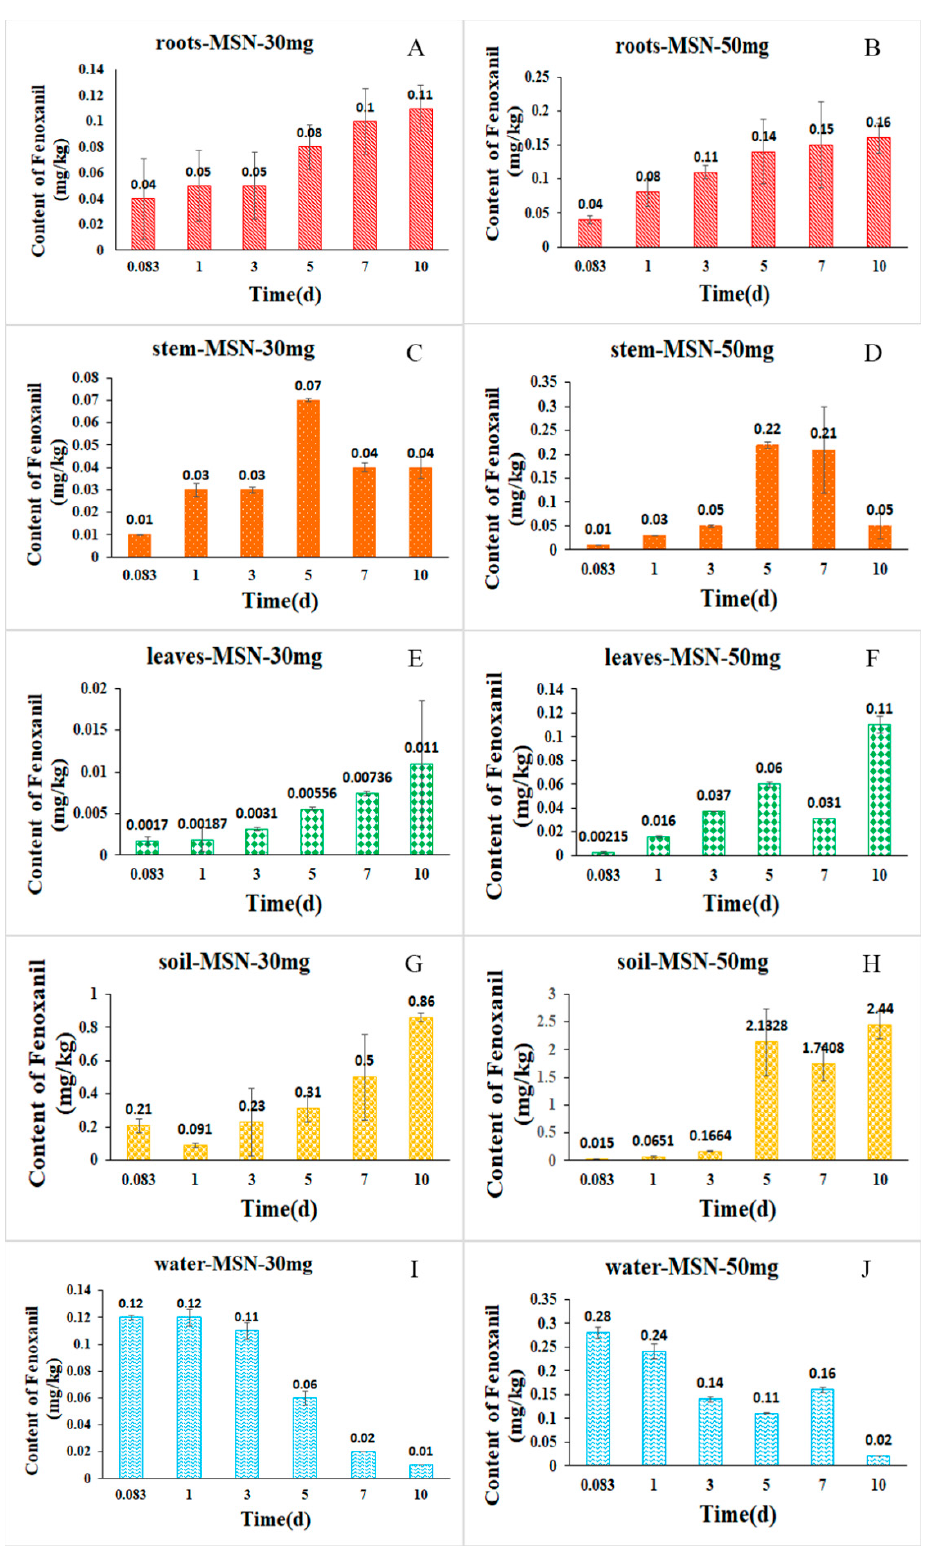
Figure 8. Distribution of Fennoxanil in rice plants: ( A ) roots with 30 mg/L treatment; ( B ) roots with 50 mg/L treatment; ( C ) stem with 30 mg/L treatment; ( D ) stem with 50 mg/L treatment; ( E ) leaves with 30 mg/L treatment; ( F ) leaves with 50 mg/L treatment; ( G ) soil with 30 mg/L treatment; ( H ) soil with 50 mg/L treatment; ( I ) water with 30 mg/L treatment; ( J ) water with 50 mg/L treatment.